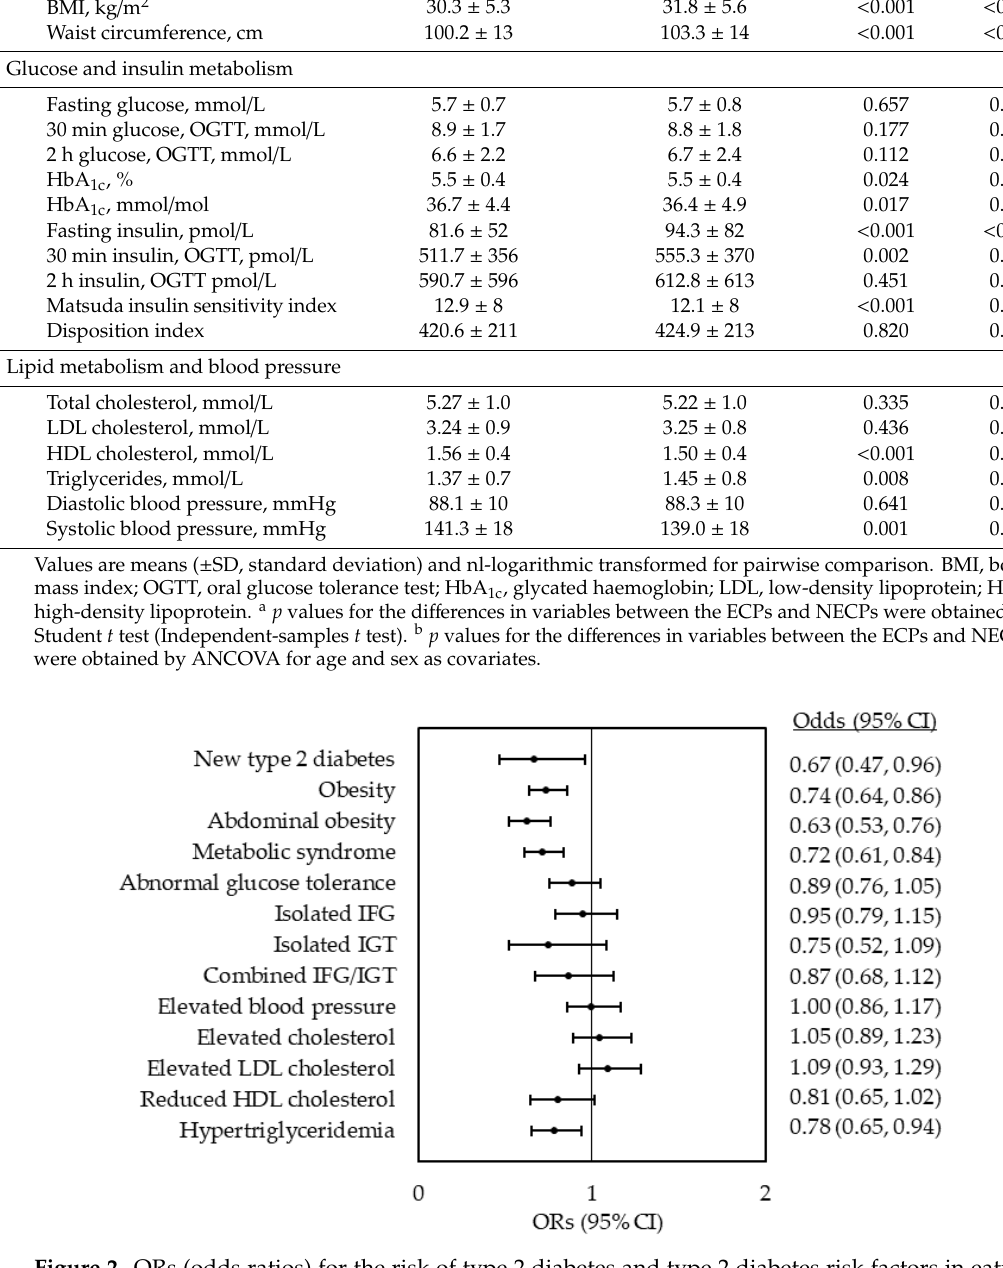
Figure 2. ORs (odds ratios) for the risk of type 2 diabetes and type 2 diabetes risk factors in eating competent participants (ECPs) (score ≥32) compared with not eating competent participants (NECPs)